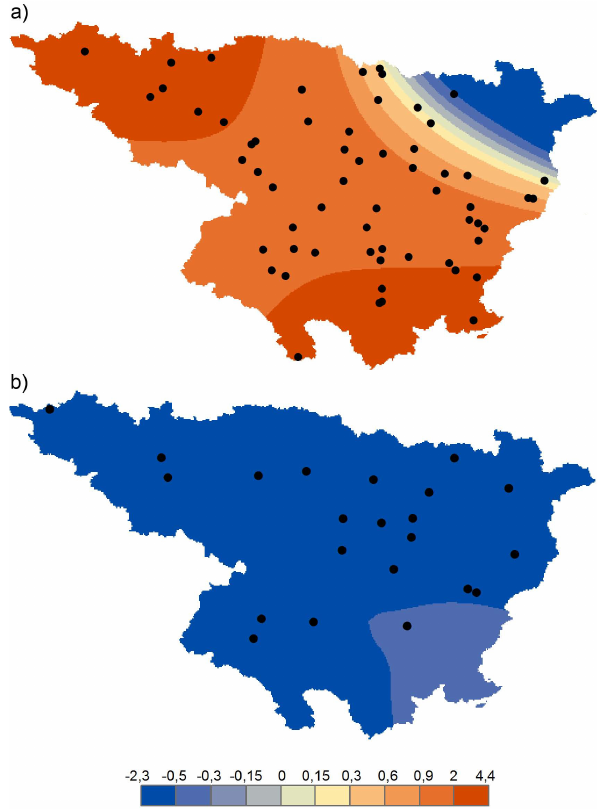
Fig. 6. Per decade change in the number of daily rainfall erosivity events corresponding to (a) the first (Q1) and (b) fifth (Q5) quintiles at the annual scale for the period 1955–2006. Black circles indicate significant trends at the α = 0 . 05 confidence level.